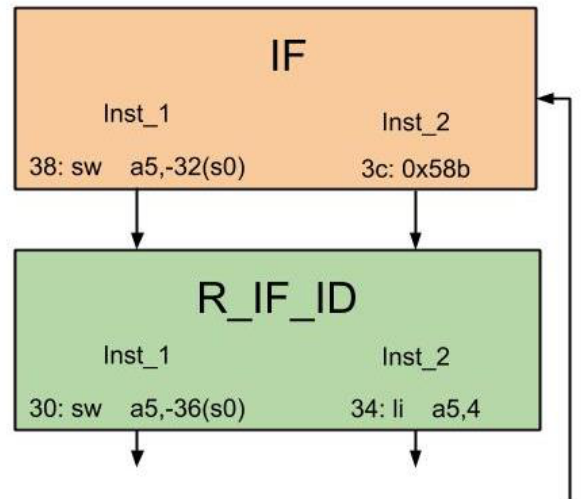
Figure 3. Trace’s instruction pair fetch